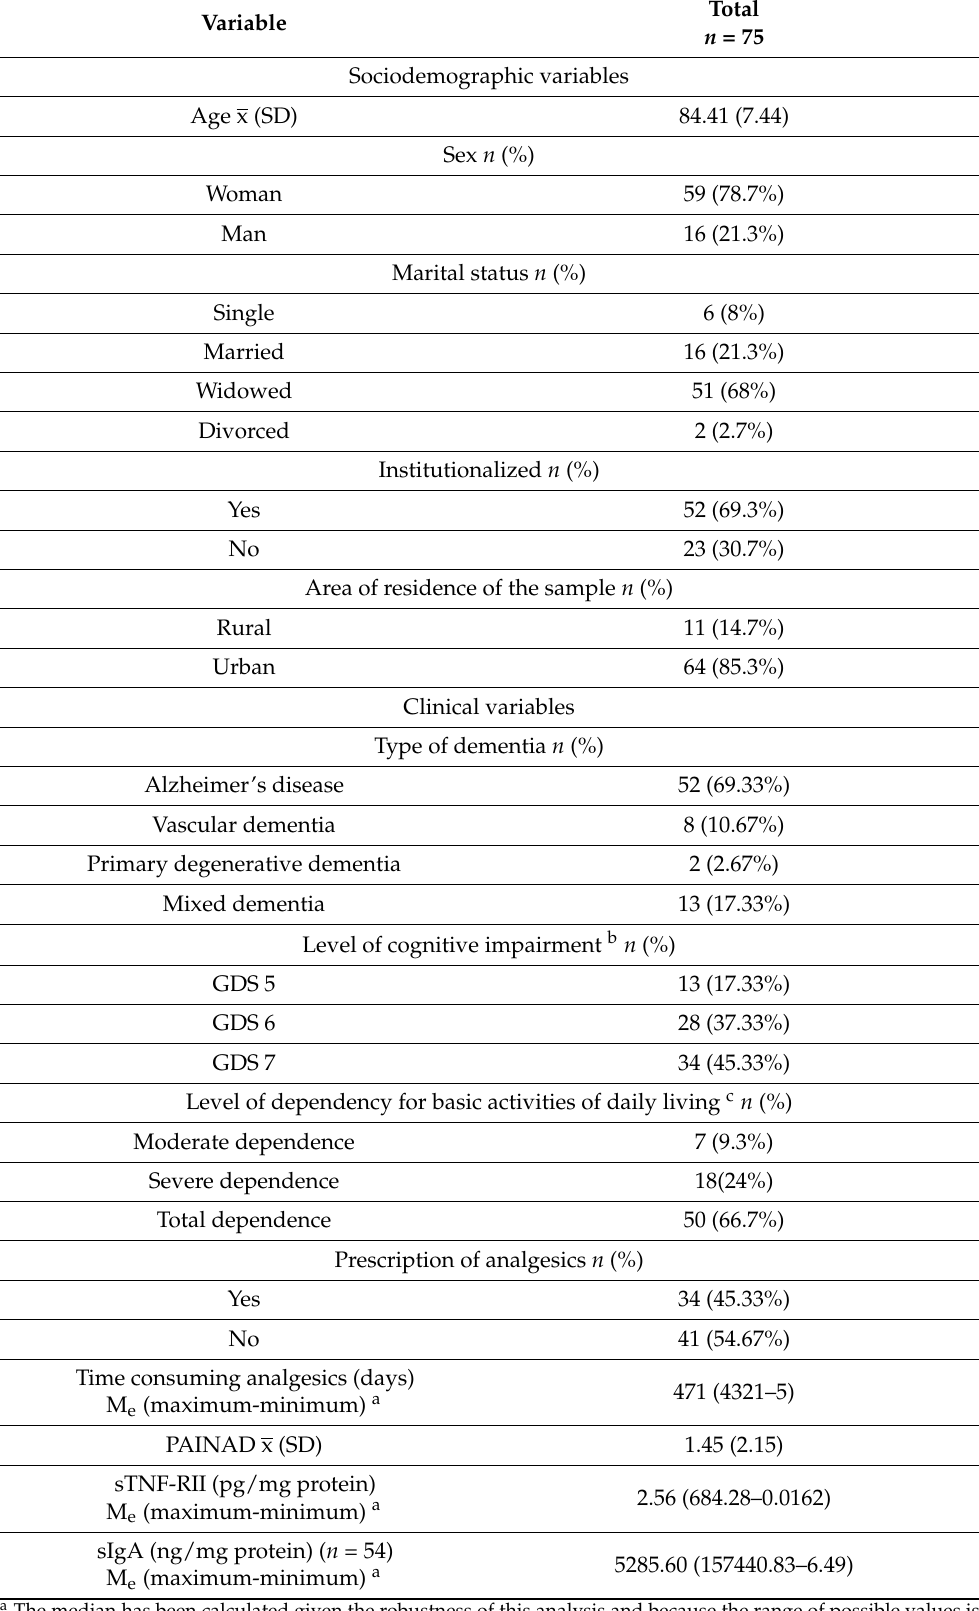
Table 1. Description of the